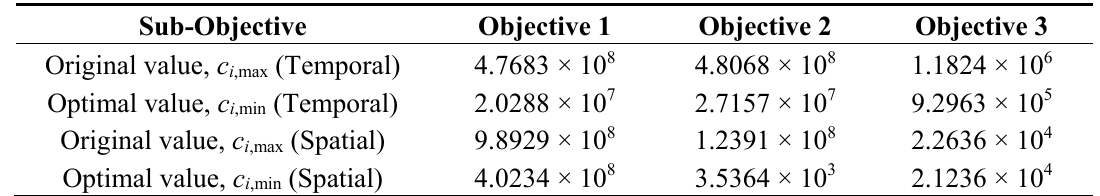
Table 3. Upper and lower sub-objective limits.